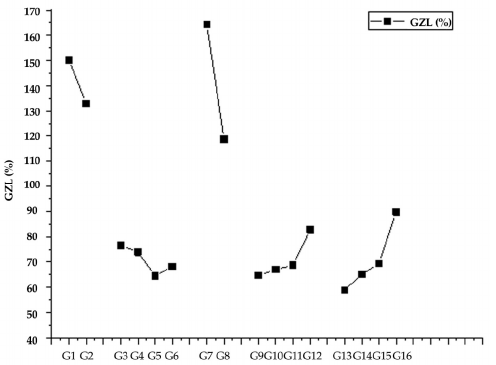
Figure 2. Change trend chart of factor and level for the effect of GZL (%).